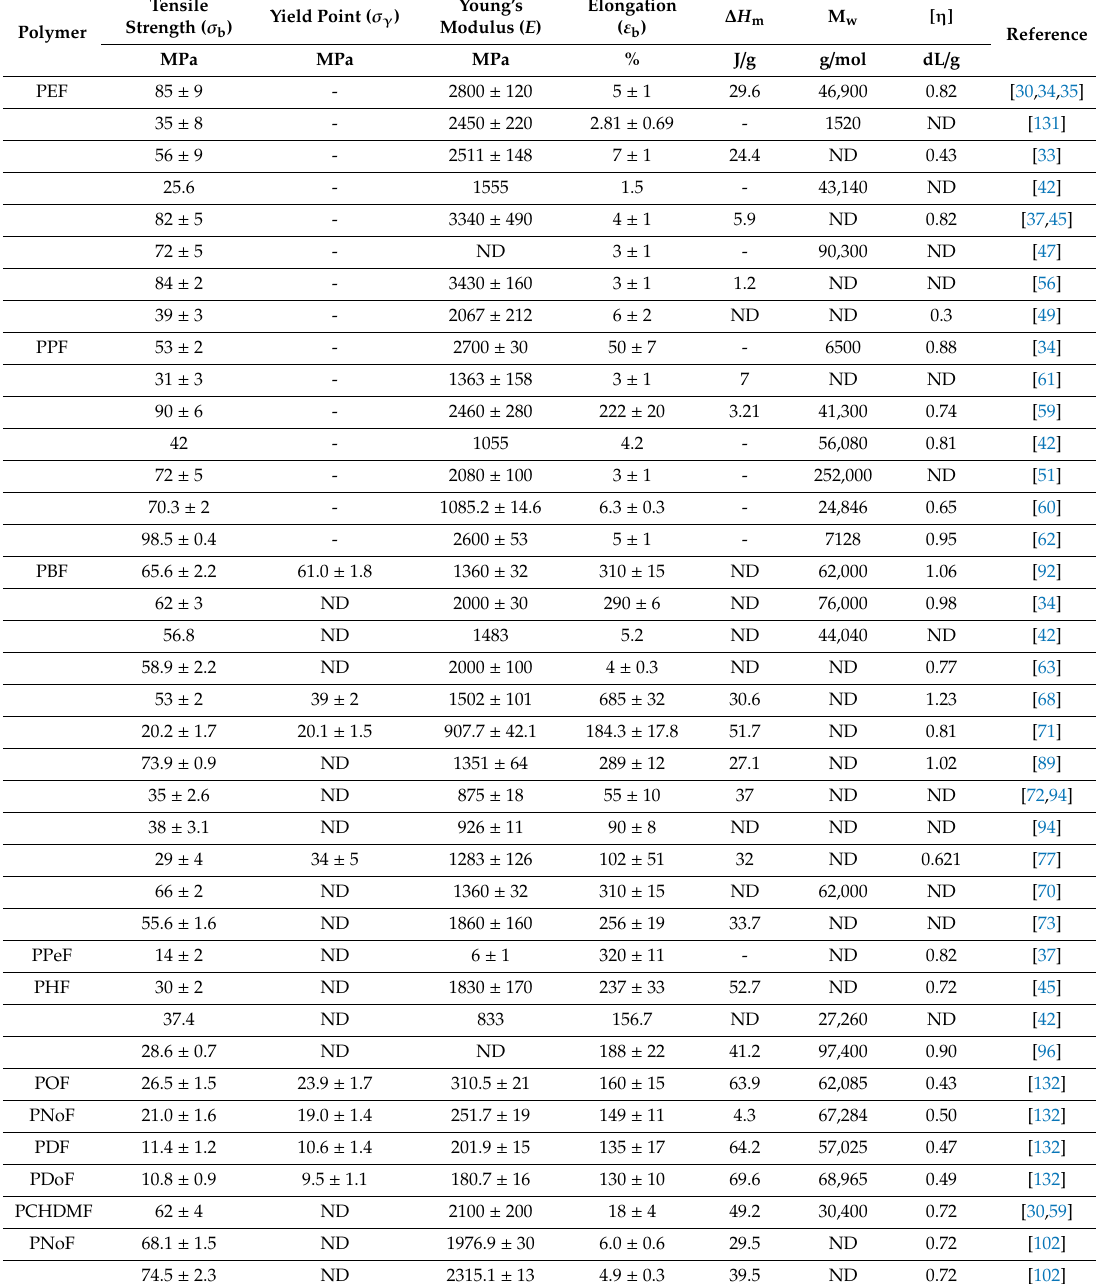
Table A1. Mechanical properties of FDCA-based homopolymers (ND = not